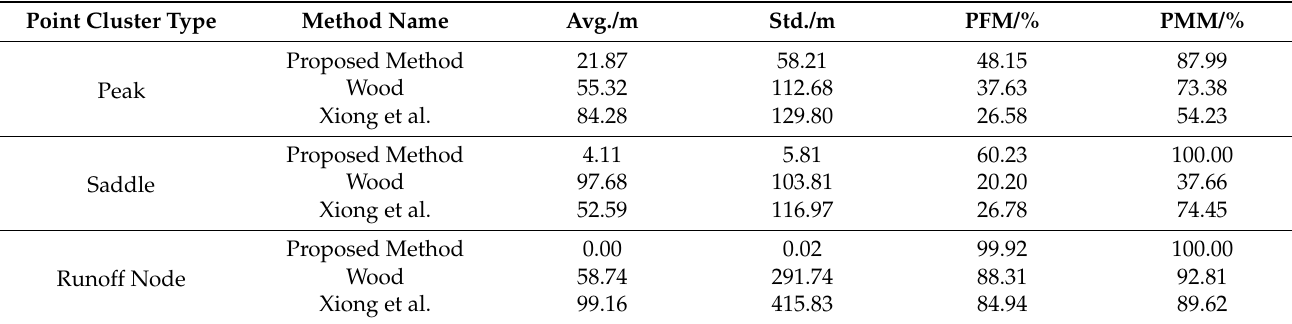
Table 2. Relative localization errors of extracted point